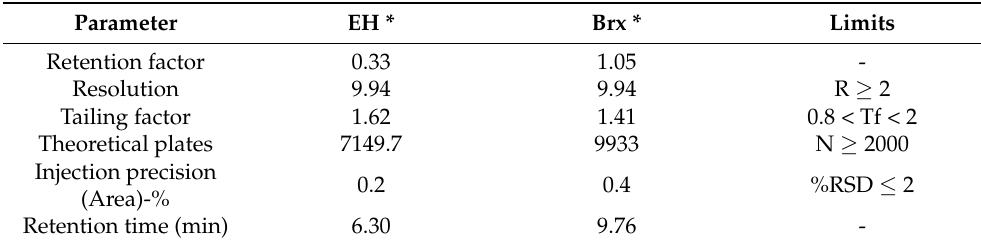
Table 3. System suitability testing of optimum